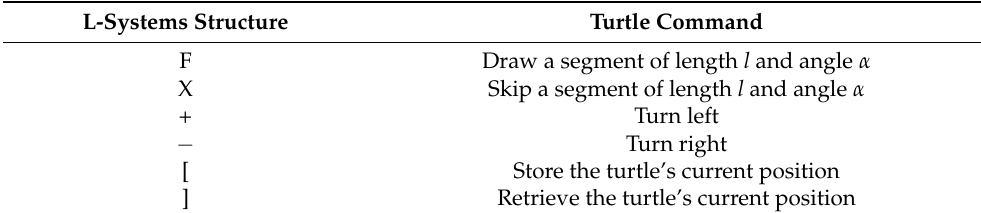
Table 1. L-systems’ structure and related turtle commands.